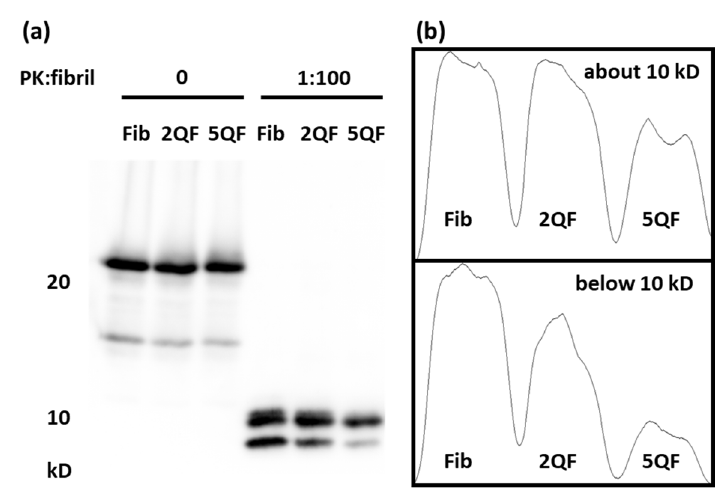
Figure 3. The PK-digested fragments shown in ( a ) immunoblotting by antibody SAF-84. ( b ) Densitometric quantification of PK-resistant fragments. The densitometric patterns in the top and the bottom represents the fragments locate at about 10 kD and below 10 kD, respectively.